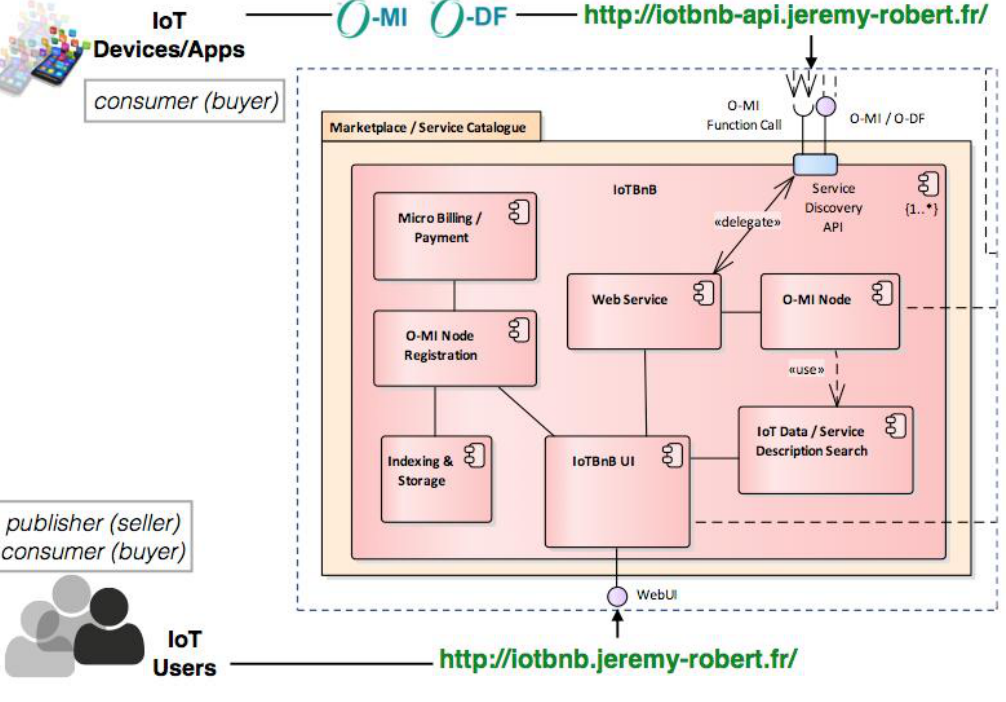
Figure 2. IoTBnB internal components.